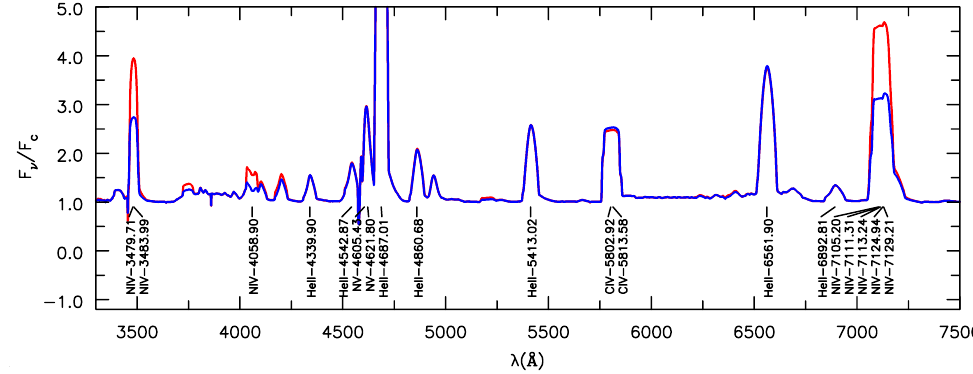
Figure 8. Illustration of the influence of LTDR on the strength of several N IV emission lines. The model in red is the full calculation, while for the blue spectrum we omitted LTDR transitions in the calculation of the nLTE populations. A N IV transition at 1718Å is also influenced by LTDR. For these calculations we used smooth N IV photoionization cross-sections and the LTDR data of [81,82]. Calculations using the opacity photoionization cross-sections of [111], that were obtained from [22], yield a spectrum very similar to that shown in red. The model has a luminosity of 3 × 10 5 L (cid:12) , a radius (at a Rosseland optical depth of 2/3) of 2.9 R (cid:12) , an effective temperature of ∼ 78,000K, a mass-loss rate of ˙ M = 1.5 × 10 − 5 M (cid:12) yr − 1 , and a volume filling factor (which characterizes the degree of clumping in the wind) of